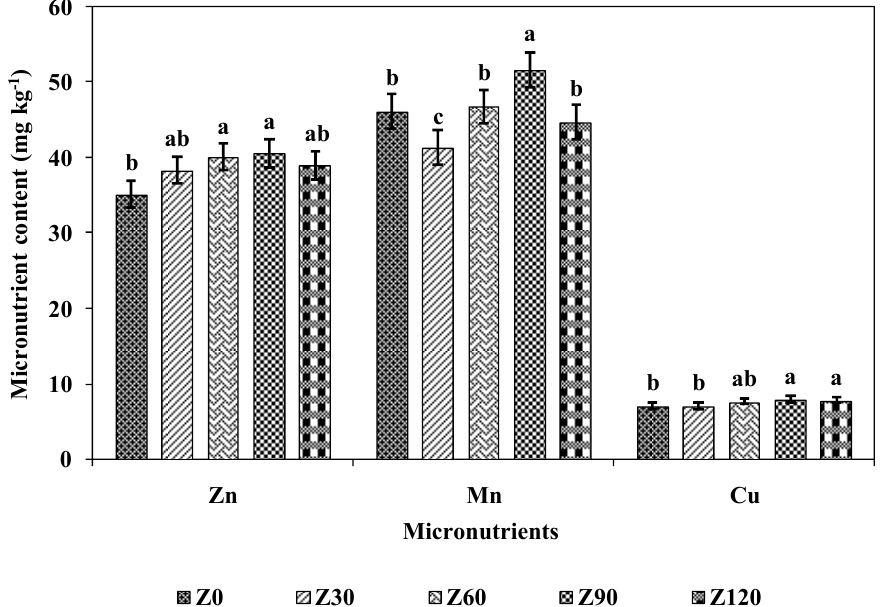
Figure 9. Micronutrient content in bean leaves with different levels of zeolite application (Z 0 : 0; Z 30 : 30; Z 60 : 60; Z 90 : 90; Z 120 : 120 t ha − 1 ); within treatments, different letters indicate significant differ- ences at p ≤ 0.05(otherwise statistically at par); error bars represent the least significant difference value. Modified after Ozbahce et al. [33].